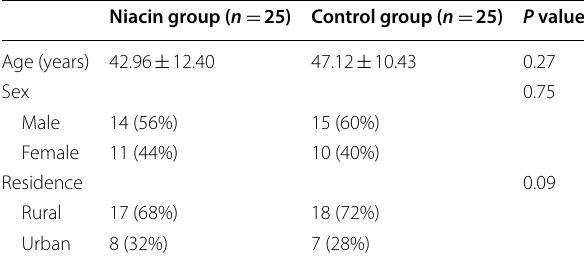
Table 1 Demographic data of studied groups